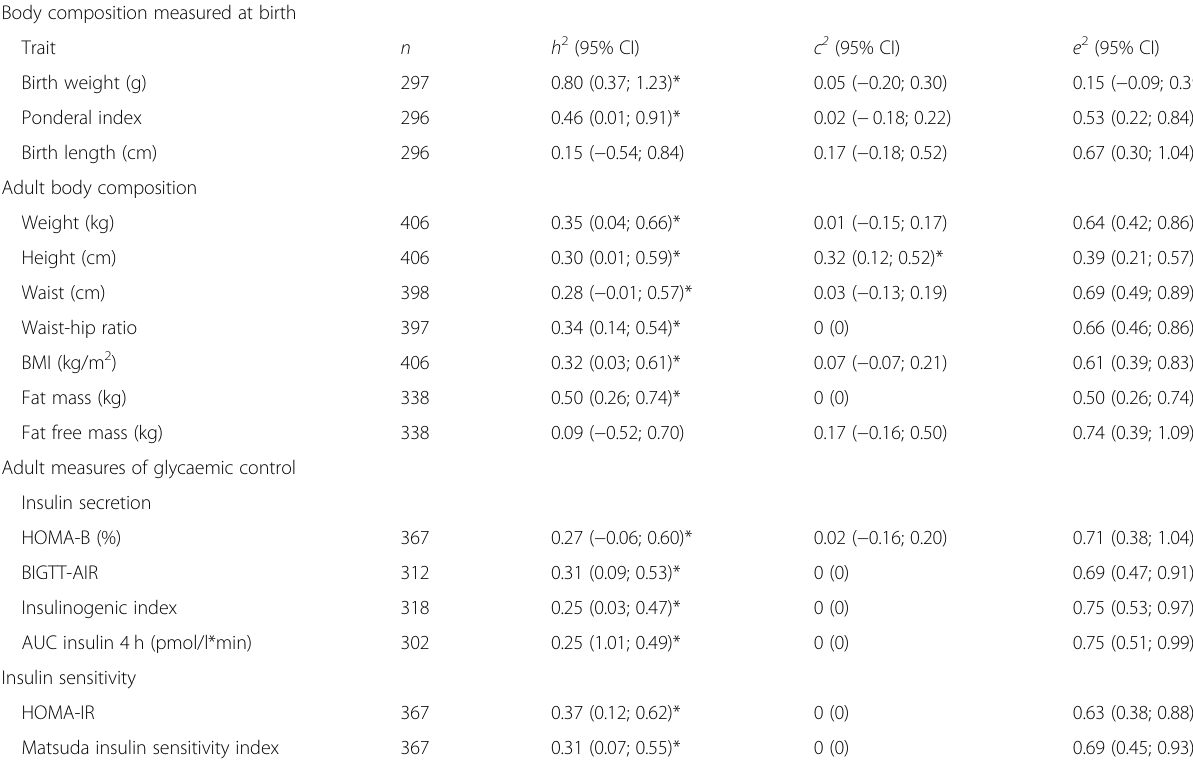
Table 3 Heritability estimates Body composition measured at birth